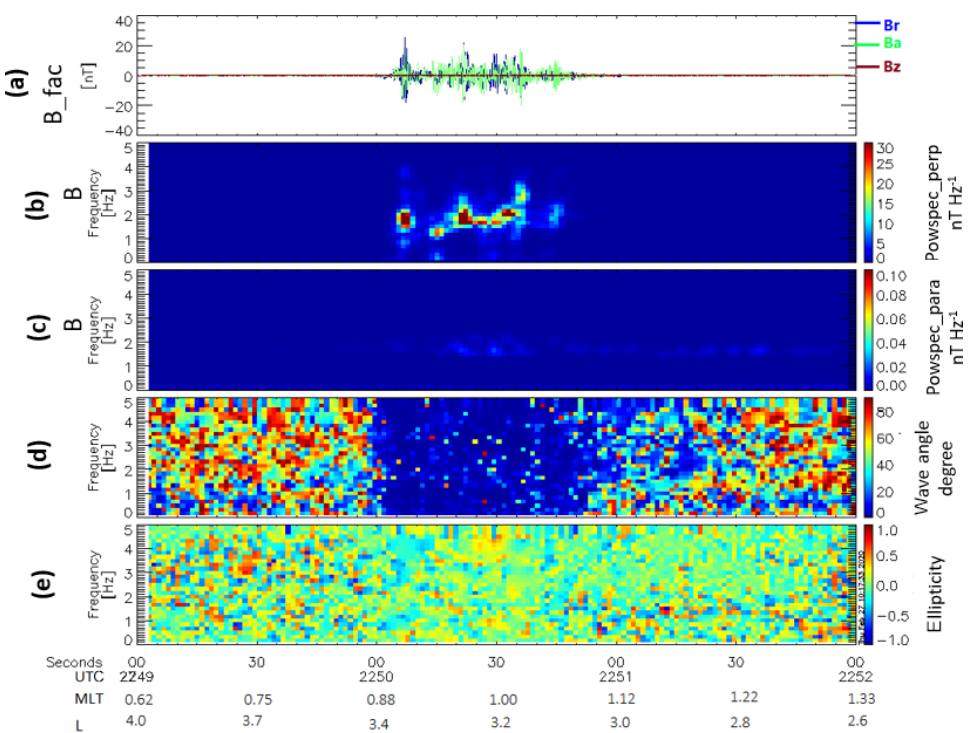
Figure 7. The wave propagation and polarisation features of the Pc1 waves observed by Swarm. From top to bottom: (a) magnetic field components (including perpendicular components B a and B r marked in blue and green and the parallel component B z marked in red); wave power spectrum in (b) perpendicular and (c) parallel directions; and (d) wave normal angle and (e) ellipticity computed by the wave vector analysis of Means (1972), where positive indicates right-handed polarisation and negative indicates left-handed